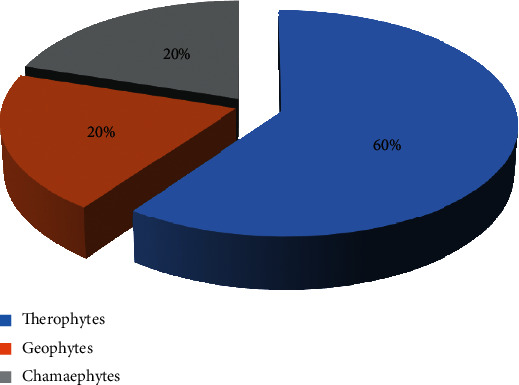
Life-form classes.